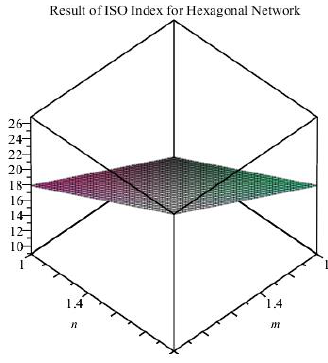
Figure 10. Result of ISO index for the hexagonal network.